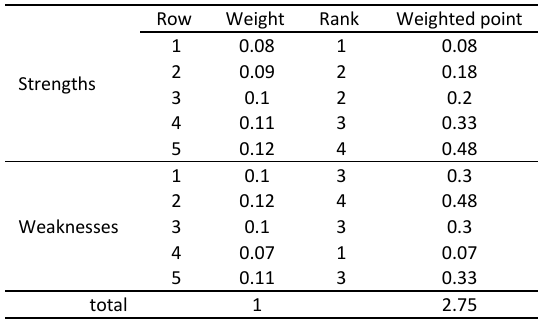
Table 7: Internal factors